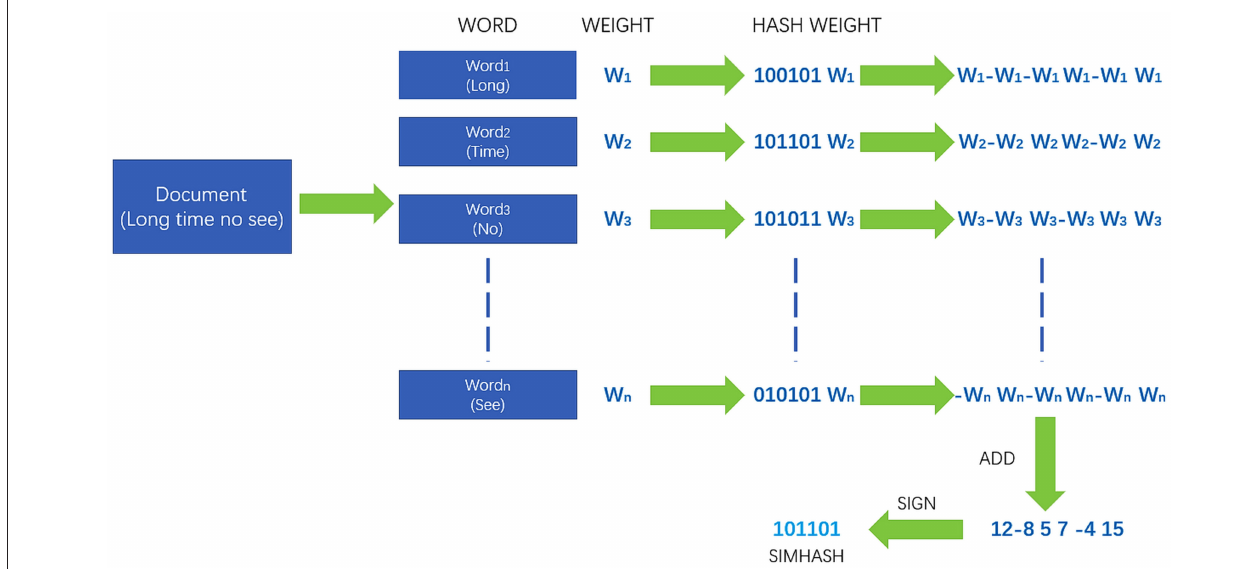
FIGURE 2 | Simhash algorithm flow.